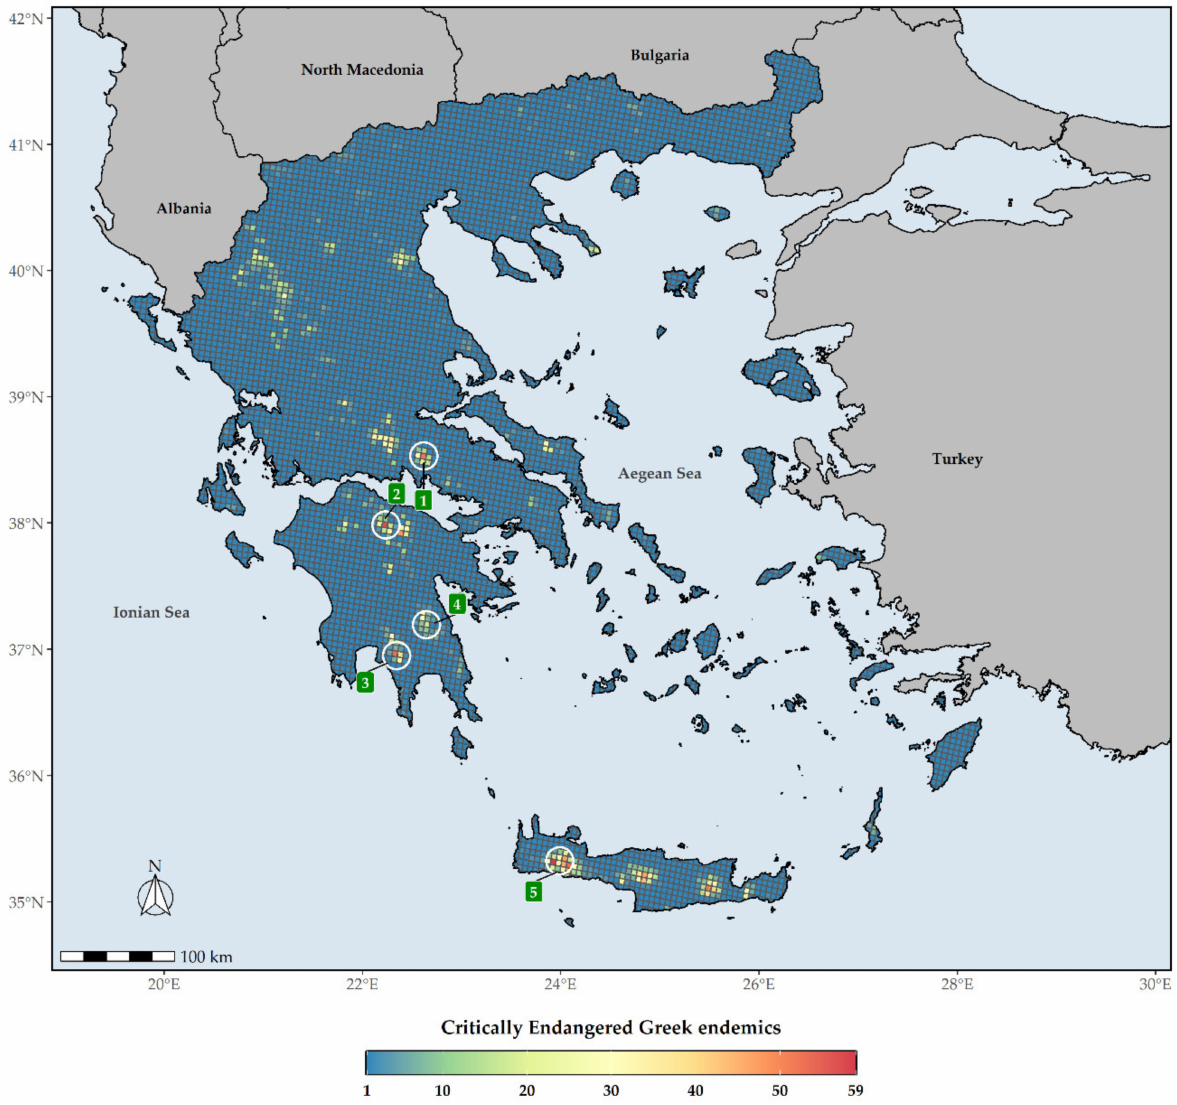
Figure 7. Species richness in Greece regarding Critically Endangered Greek endemic taxa (CR END ) for every grid cell in Greece. Grid cell resolution equals to ca. 5 km. 1: Mt. Parnassos, 2: Mt. Chelmos, 3: Mt. Taygetos, 4: Mt. Parnonas, 5: Lefka Ori mountain range. The white circles delineate (roughly) the aforementioned mountains and mountain